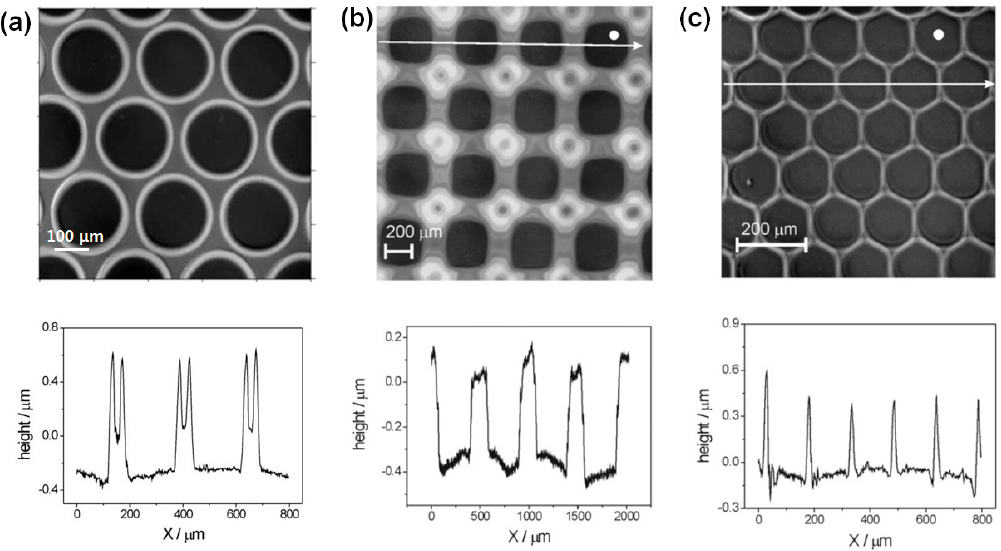
Figure 2. ( a ) Hole array in polystyrene (PS) etched by inkjet printing with isopropyl acetate [33]. Copyright 2007 Royal Society of Chemistry. ( b ) Rectangular holes in PS inkjet-etched with acetophenone droplets. ( c ) Hexagonal holes inkjet-etched with isopropyl acetate droplets. The surface profiles are shown beneath the images [32]. Copyright 2006 Wiley.